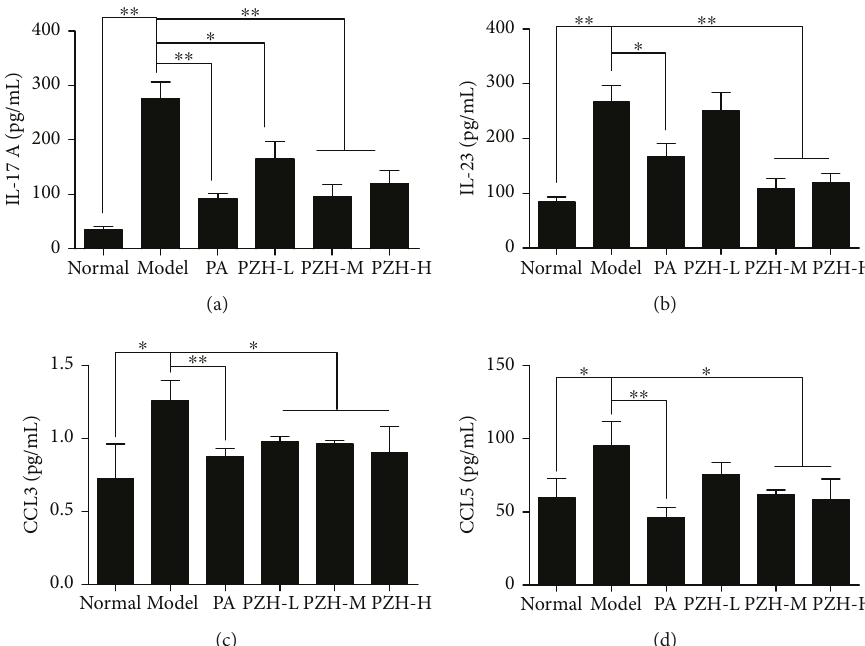
Figure 4: PZH reduced proin fl ammatory cytokine and chemokine expression in serum of EAE rats. Rats were sacri fi ced, and the serum was collected for ELISA analysis. The levels of IL-17A (a), IL-23 (b), CCL3 (c), and CCL5 (d) were shown, respectively. Data are shown as the mean ± SD. ∗ P < 0 05 and ∗∗ P < 0 01 .